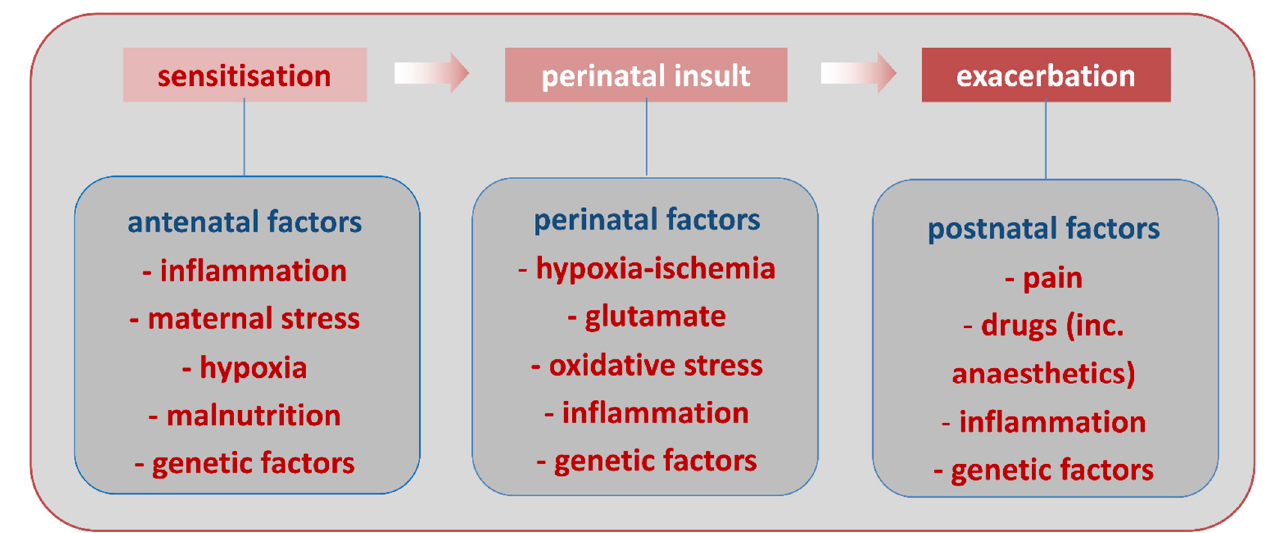
Figure 3. Schematic representation of the multiple-hit hypothesis in PBIs, based on citations from within [21,81] and others in this review.